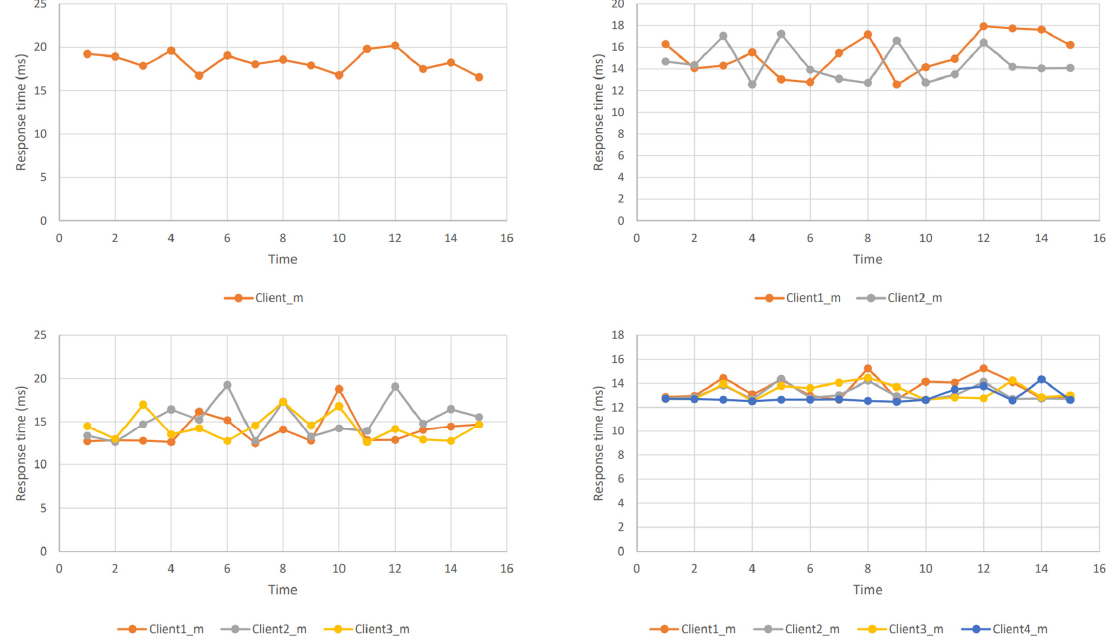
Figure 9. Response time comparison according to the number of connected LiDARs.